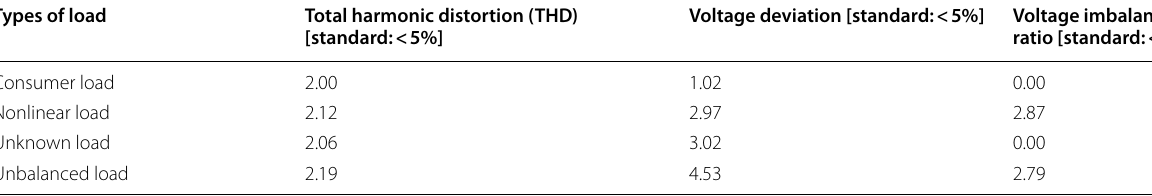
Table 10 Power quality constraints measurement with the designed MIMO NI‑RLLC controller Types of